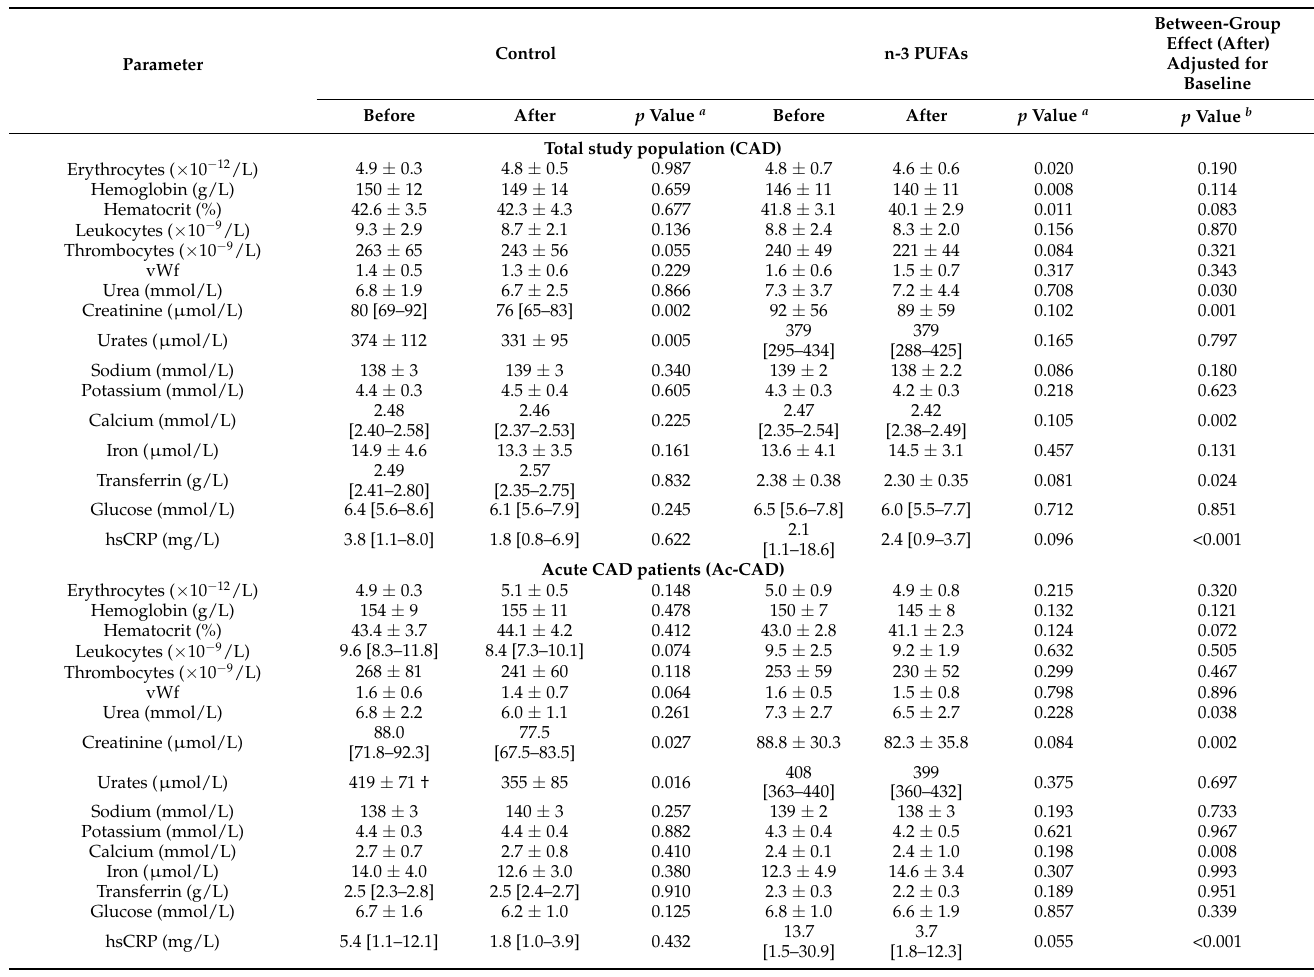
Table 3. The effect of regular (control group) and n-3 PUFA-enriched hen eggs (n-3 PUFAs group) consumption on biochemical parameters in the total population (CAD) and in the two subgroups (Ac-CAD patients and Ch-CAD patients). Control n-3 PUFAs Parameter